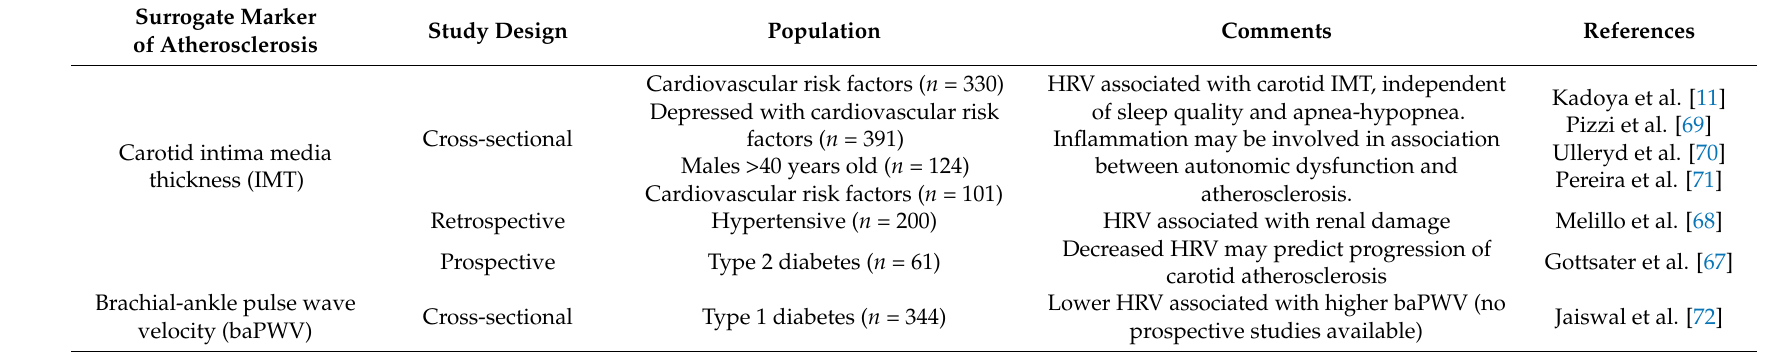
Table 4. Associations of HRV with carotid IMT and